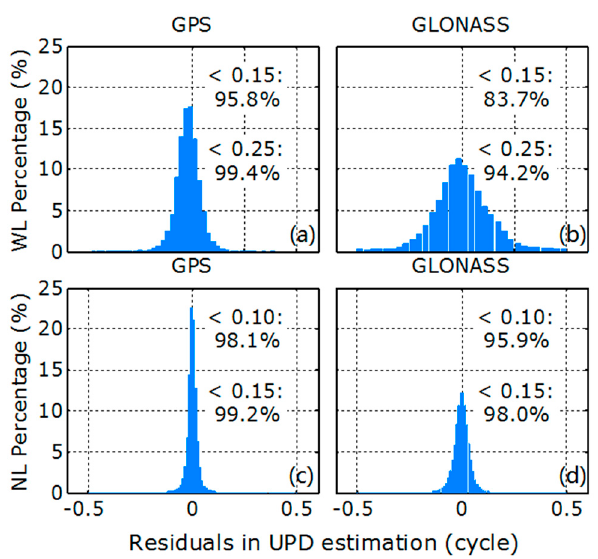
Figure 3. Distribution of a posteriori residuals of the wide-lane (WL) ( a , b ) and narrow-lane (NL) ( c , d ) float ambiguities for Global Positioning System (GPS) and Globalnaya Navigatsionnaya Sputnikovaya Sistema (GLONASS) (( a , c ) to ( b , d )) in uncalibrated phase delay (UPD) estimation with reference stations. Remote Sens. 2018 , 10 , x FOR PEER REVIEW